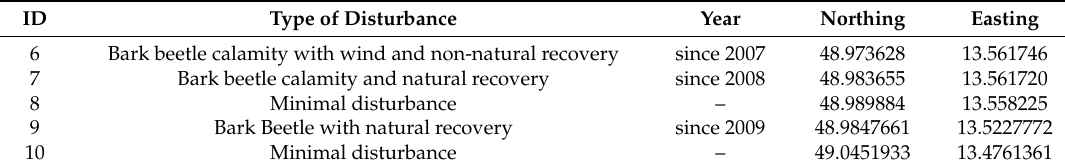
Table 2. Overview of the selected localities in the Sumava NP with the GPS position in WGS 84.